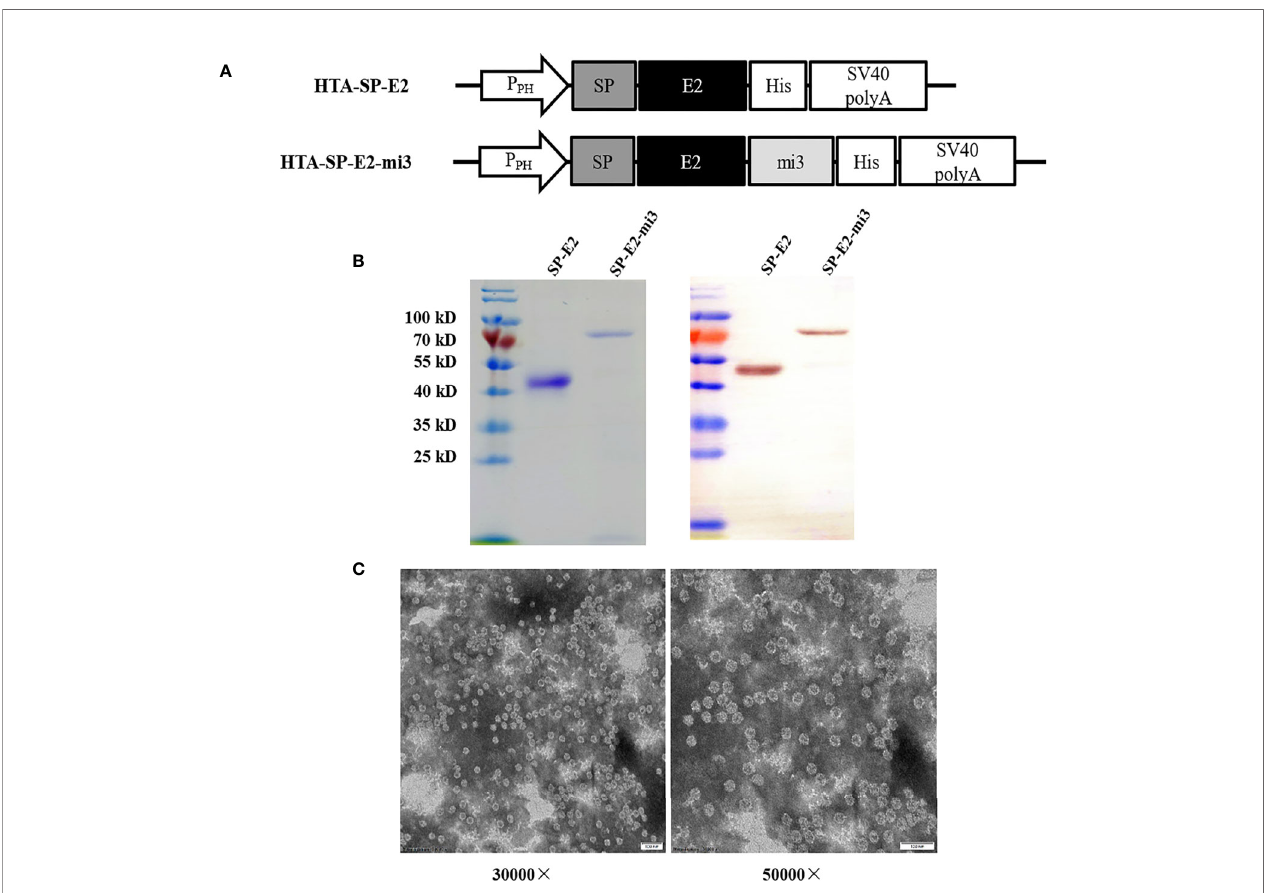
FIGURE 1 | Expression and self-assembly analysis of mi3 fusion proteins. (A) Schematic diagram of baculoviral constructs for eukaryotic expression. P PH : AcMNPV polyhedrin promoter, mi3: self-assembling protein, SV40 polyA: SV40 polyadenylation signal. (B) Analysis of puri fi ed SP-E2 and SP-E2-mi3 proteins in SDS-PAGE (left) and Western blot (right). The target proteins were detected with E2 monoclonal antibody 3C12. (C) TEM analysis of self-assembly capacity of SP-E2-mi3 fusion